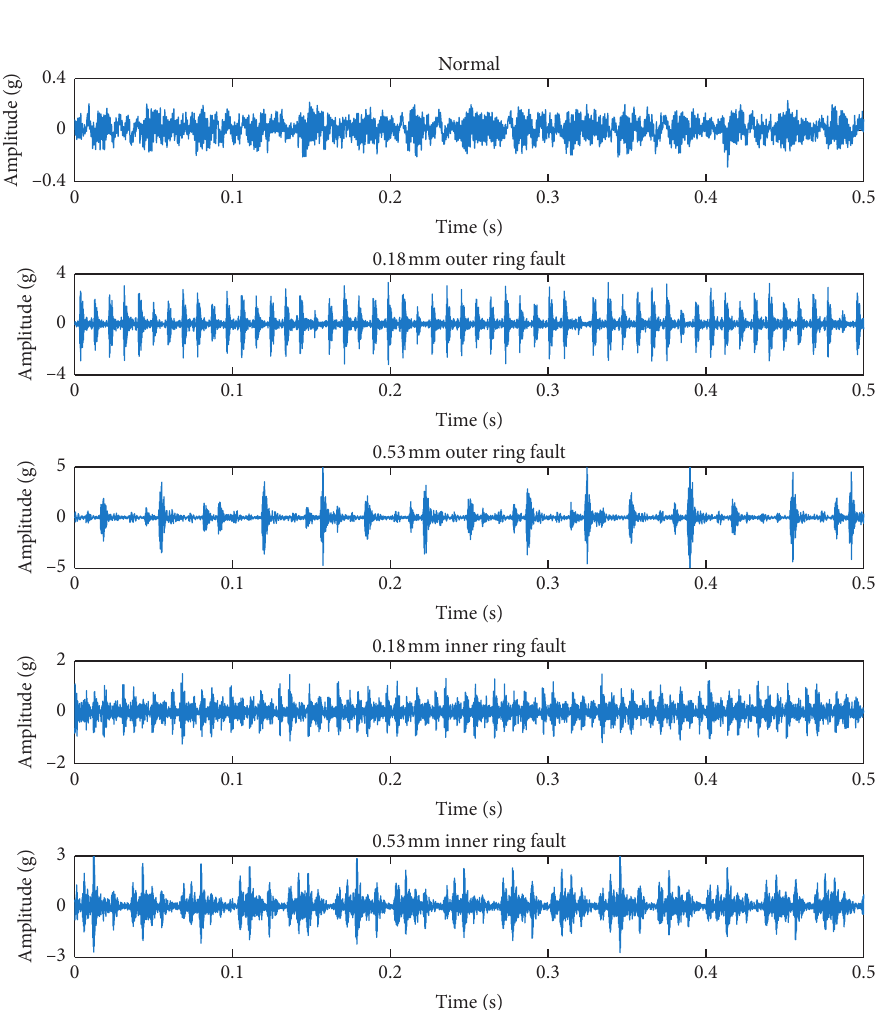
Figure 22: Part of bearing vibration signals.